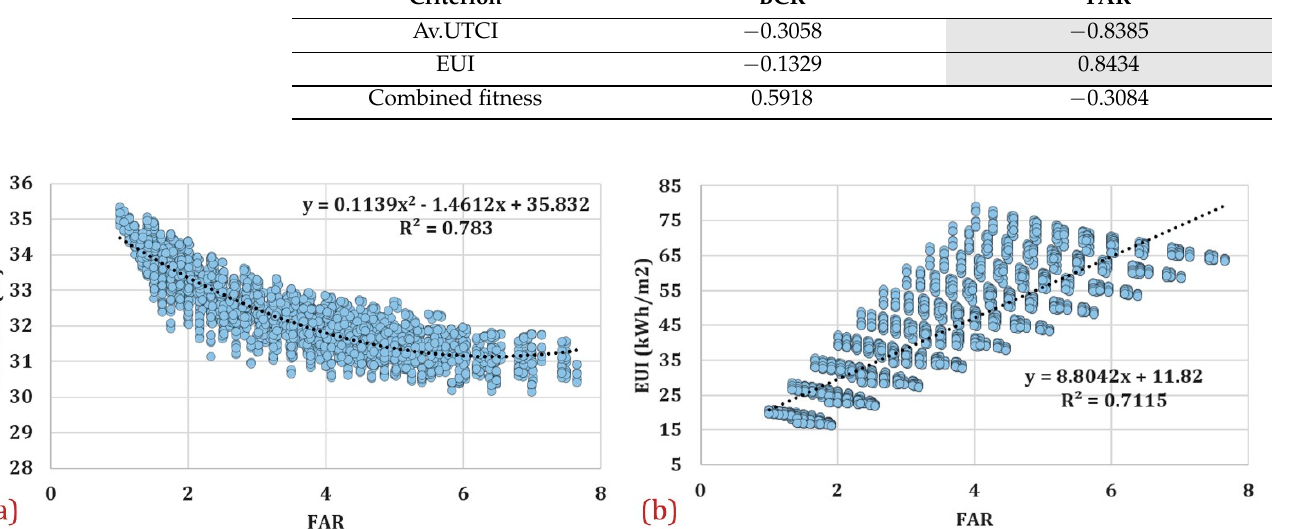
Figure 8. Relationship between FAR and (a) Av.UTCI, and (b) EUI.